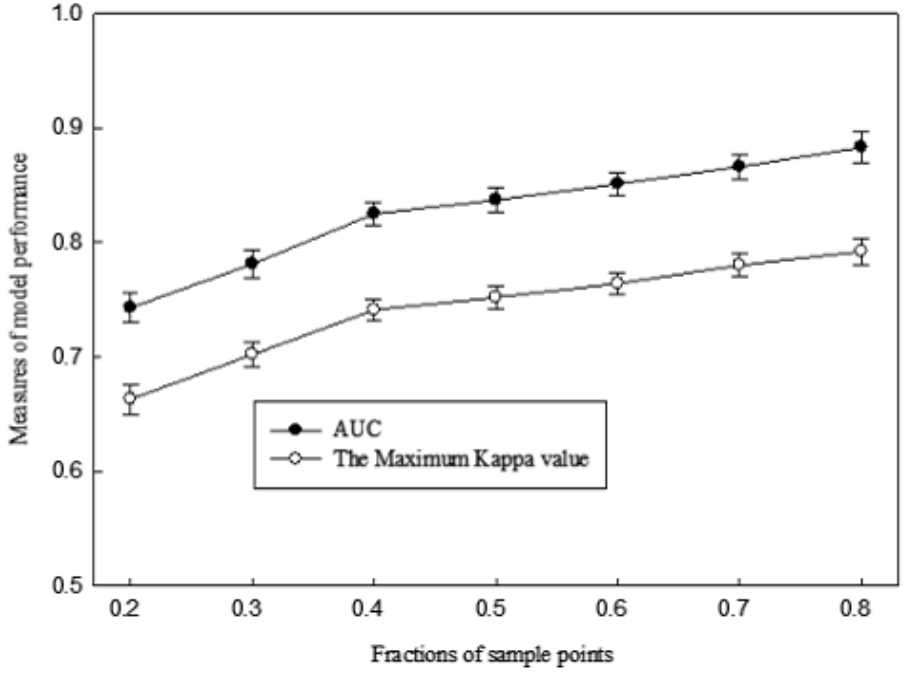
Figure 5. The area under the curve (AUC, mean ± SD) and the maximum kappa value for 10 iterations of the Maxent model as a function of increasing fraction of sample points for the Daxinganling region in China (AUC is the area under the curve of the sensitivity vs. 1—specificity